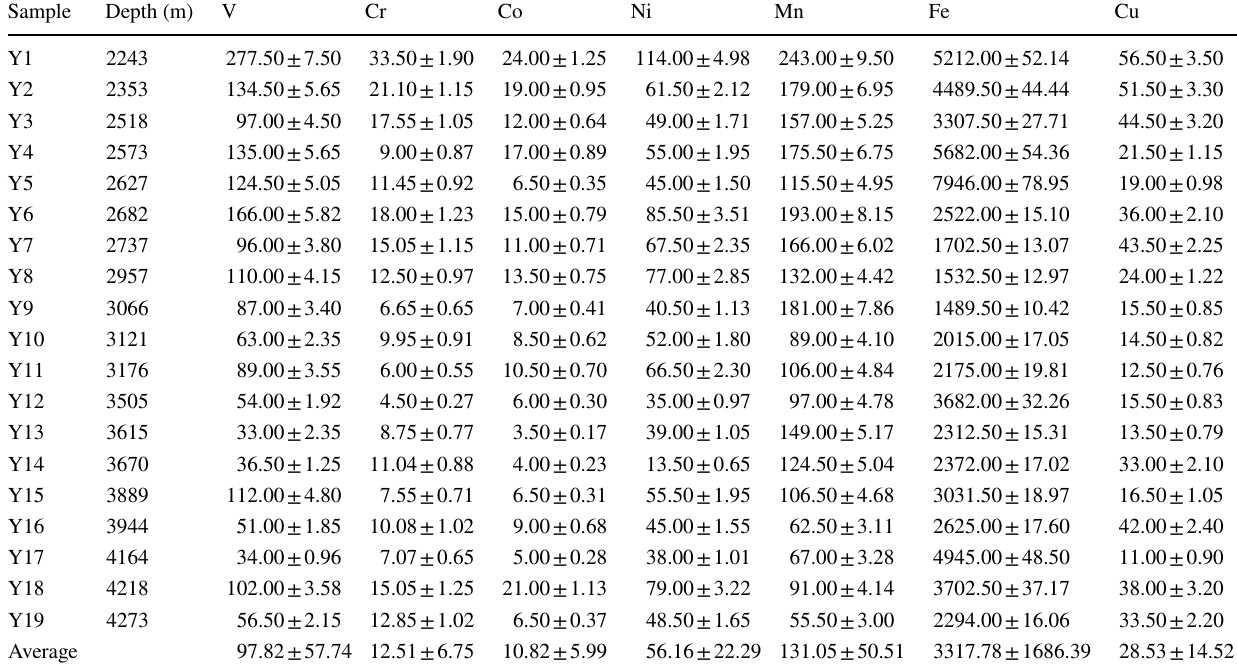
Table 2 Trace elements composition (in ppm) of kerogens from Well Y in the central Niger Delta